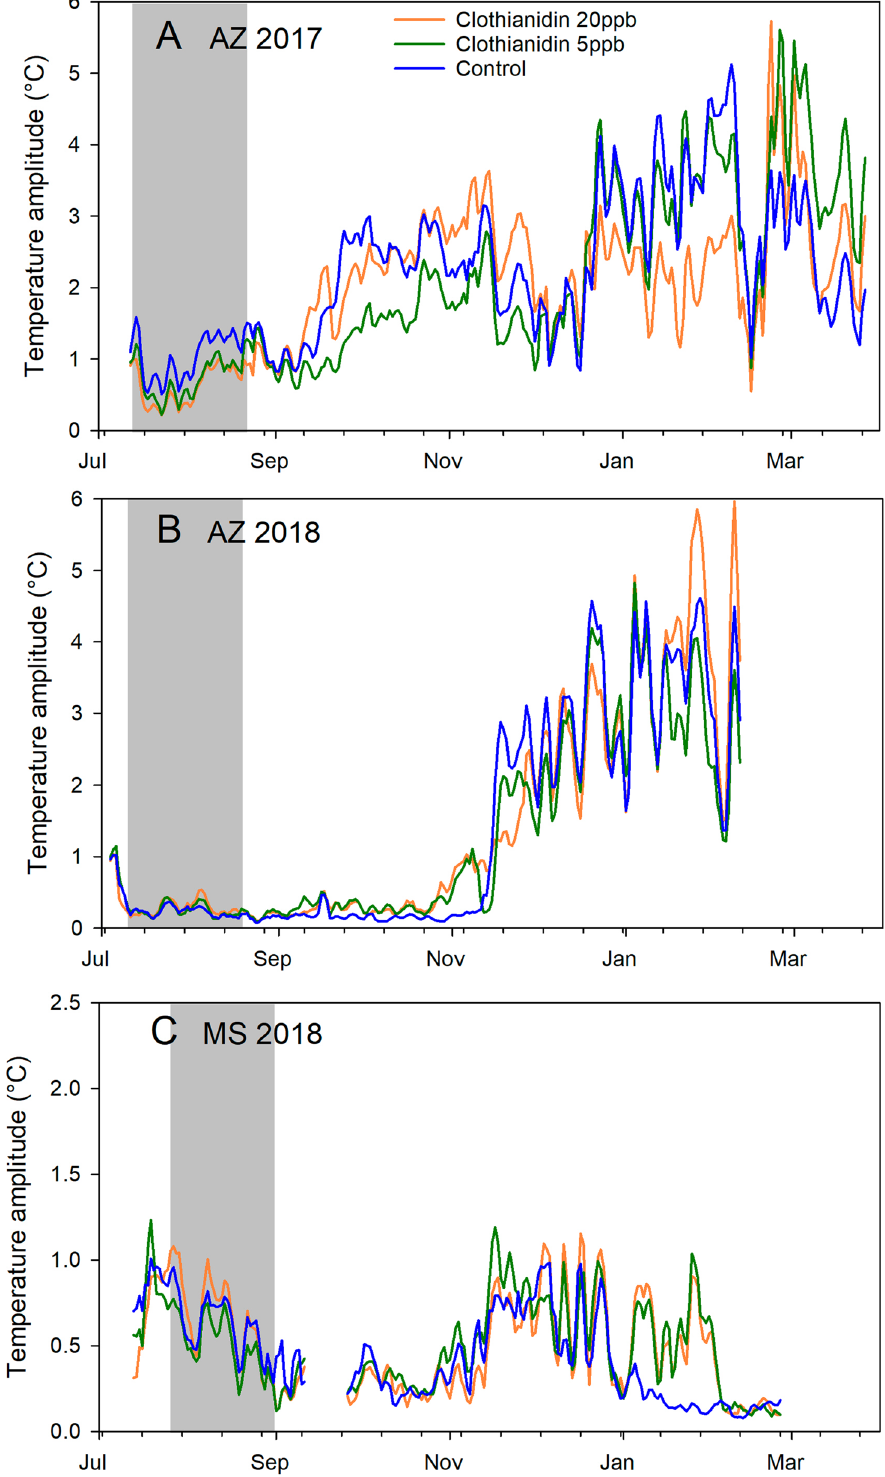
Figure 7. Average daily amplitudes of sine curves fit to within-day temperature changes per day (see text for details) for each of 3 treatment groups: Clothianidin 20-ppb (orange), clothianidin 5-ppb (green), control (blue) across 3 experiments. The gray area shows the treatment period. ( A ) AZ 2017; ( B ) AZ 2018; ( C ) MS